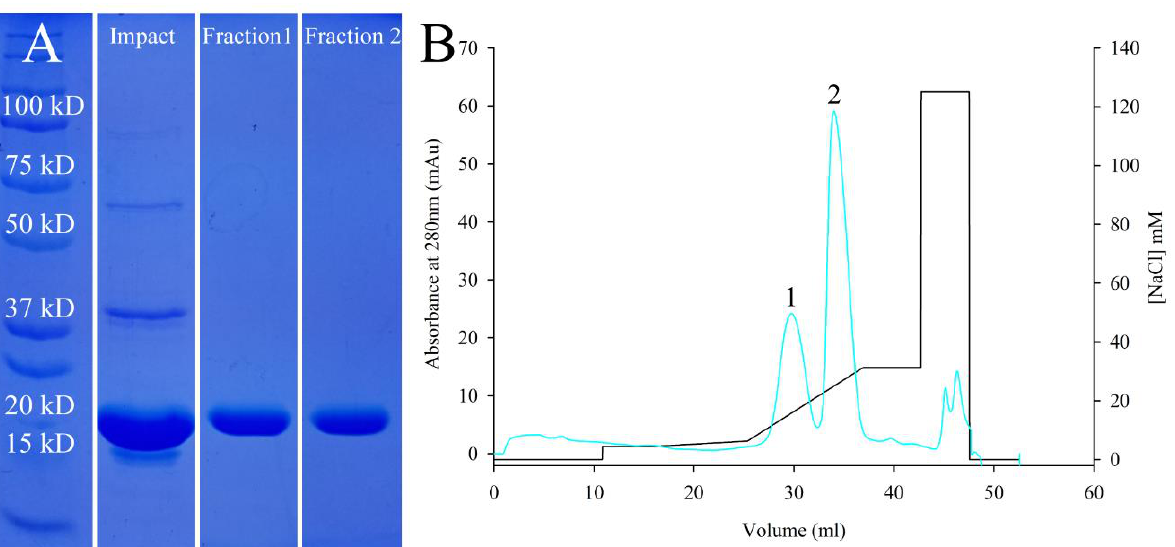
Figure 1. Purification of Af LEA1. ( A ) SDS-PAGE of crude samples obtained after affinity chromatography (IMPACT) or further purification using anion-exchange chromatography as a polishing step. Fractions 1 and 2 obtained during anion-exchange chromatography contain Af LEA1 at the expected molecular weight of ~19 kDa. ( B ) Af LEA1 binds to quaternary ammonium groups at a pH of 8.0 and elutes in two distinct fractions (blue line) at relatively low concentrations of NaCl (black line).